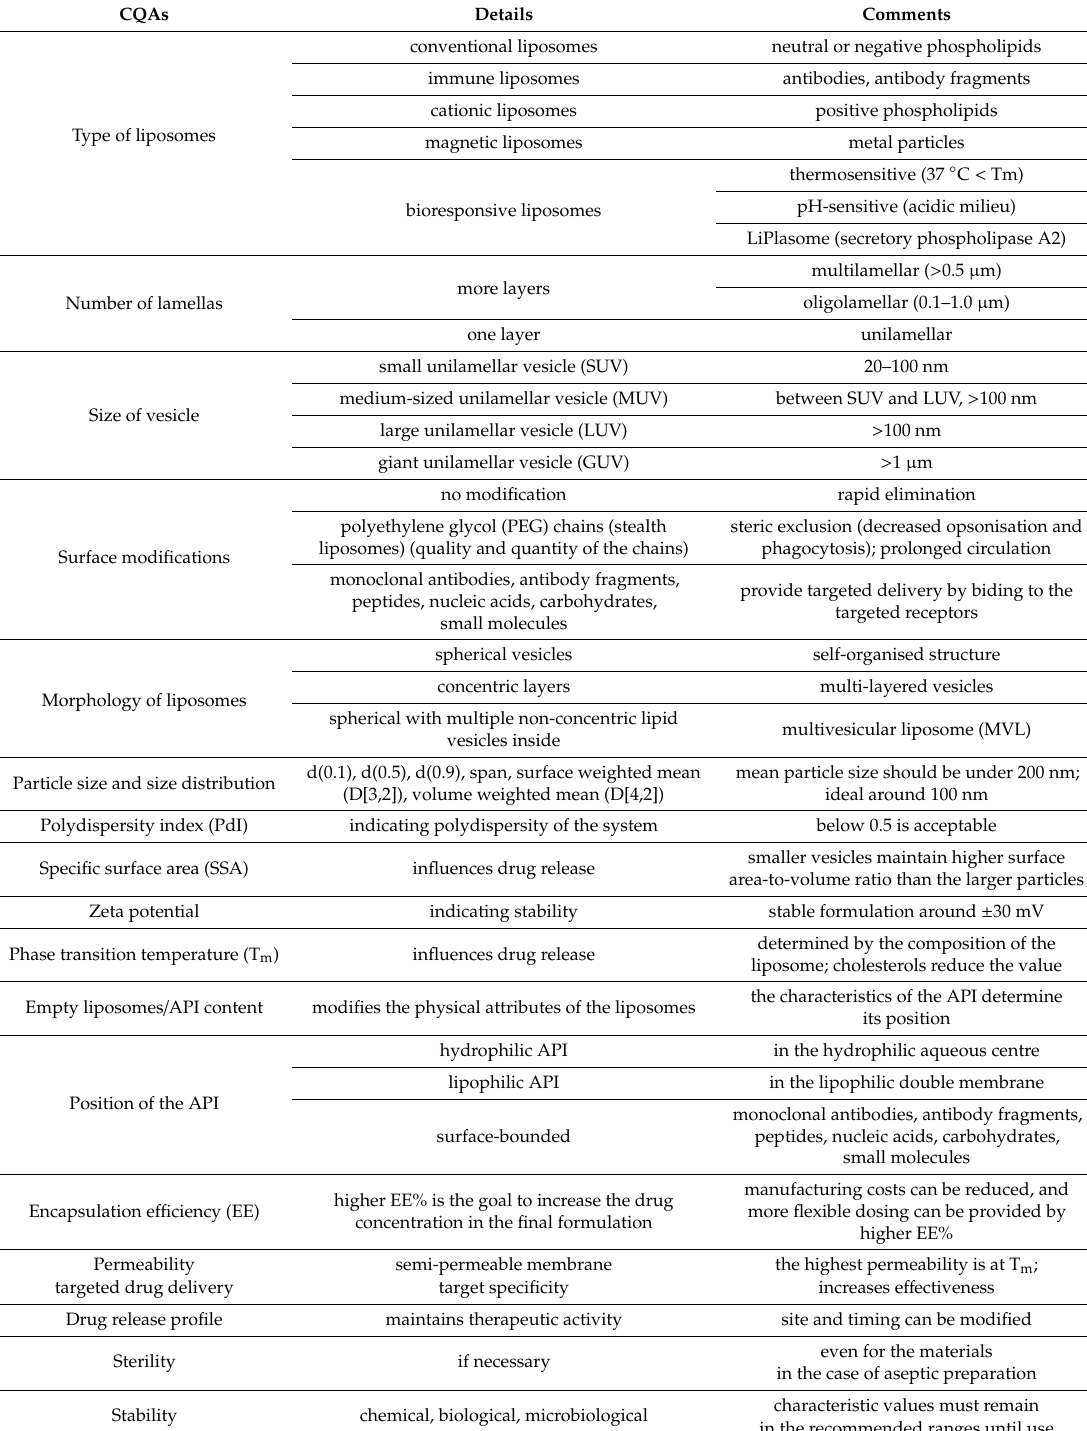
Table 3. Collection of the possible factors of critical quality attributes (CQAs) of